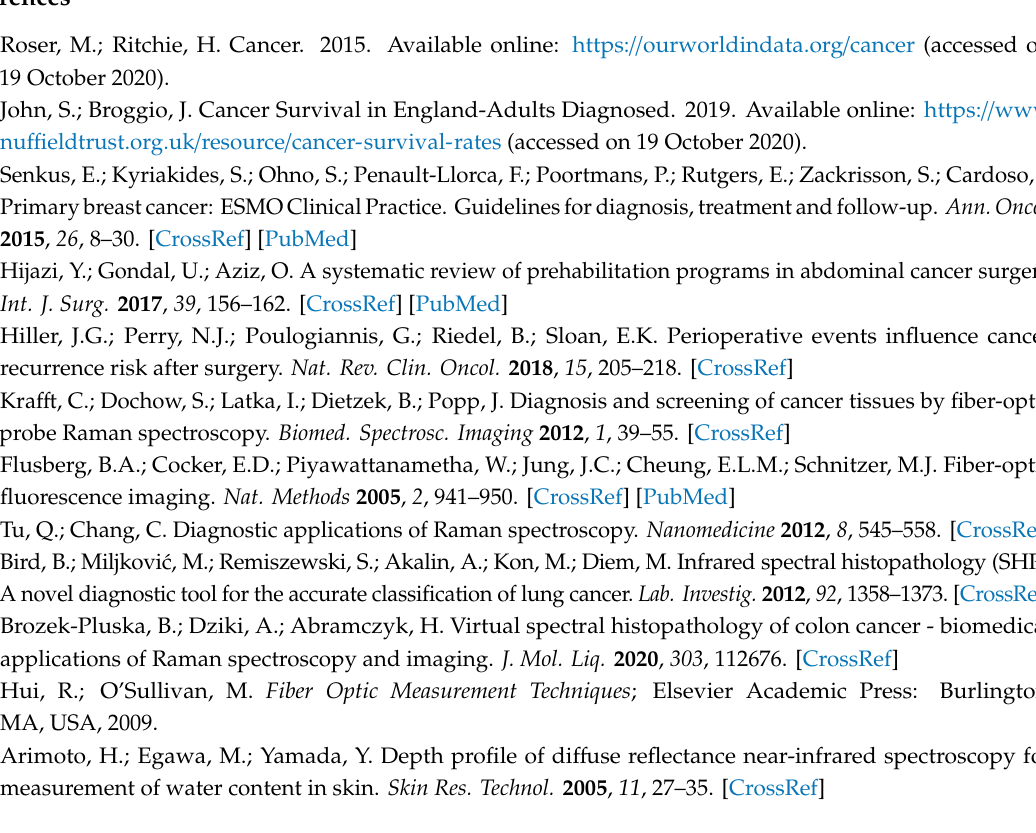
Figure S1: Calibration data (CD), including data of the three organs, of models built using single methods (before mean center removing): (a) CD of model# 2 - MIR data set pretreated by 2D, SNV; (b) CD of model# 1 - NIR data set pretreated by 2D, SNV; Figure S2. Calibration data (CD), including data of the three organs, of model #3 built using concatenated data (before mean center removing): (a) MIR part of data set pretreated by 2D, SNV; (b) NIR part of data set pretreated by 2D, SNV. Both parts normalized to [0,1]; Figure S3. Calibration data (CD) of models built using concatenated data (before mean center removing): (a) CD of model# 6 - MIR part of data set pretreated by 2D, SNV including only colon measurements; (b) CD of model# 6 - NIR part of data set pretreated by 2D including only colon measurements; (c) CD of model# 9 - MIR part of data set pretreated by 2D, SNV including only stomach measurements; (d) CD of model# 9 - NIR part of data set pretreated by SNV including only stomach measurements; (e) CD of model# 12 - MIR part of data set pretreated by 2D including only rectum measurements; (f) CD of model# 12 - NIR part of data set pretreated by 2D including only rectum measurements; Figure S4. X-loadings of models from Table 2: (a) model# 1; (b) model# 2; (c) model# 4; (d) model# 5; (e) model# 7; (f) model# 8; (g) model# 10; (h) mode # 11. Red color corresponding 1st lv, light green - 2nd lv, green - 3rd lv, blue - 4th lv, violet - 5th lv. Each curve was shifted up by 30% from the previous curve on the y-axis for better visualization of the loading plots; Figure S5. X-loadings of models from Table 2: (a,b) model# 3; (c,d) model# 6; (e,f) model# 9; (g,h) model# 12; There are two parts of each plot corresponding to the NIR (a,c,e,g) and MIR (b,d,f,h) parts of concatenated data. Red color corresponding 1st lv, light green - 2nd lv, green - 3rd lv, blue - 4th lv, violet - 5th lv. Each curve was shifted up by 30% from the previous curve on the y-axis for better visualization of the loading